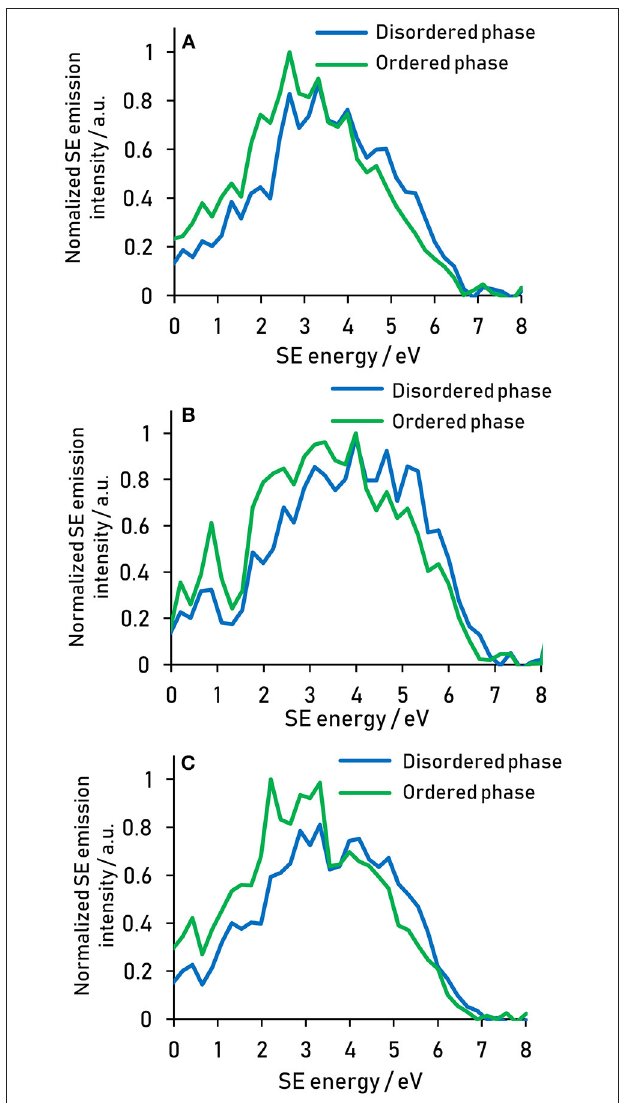
FIGURE 4 | Secondary electron spectral differences between the ordered nanostructure and the disordered matrix present after 10min plasma treatment for reeling speeds of (A) 5 (B) 20, and (C) 40mm s − 1 . Spectra acquired at 500eV primary beam energy.